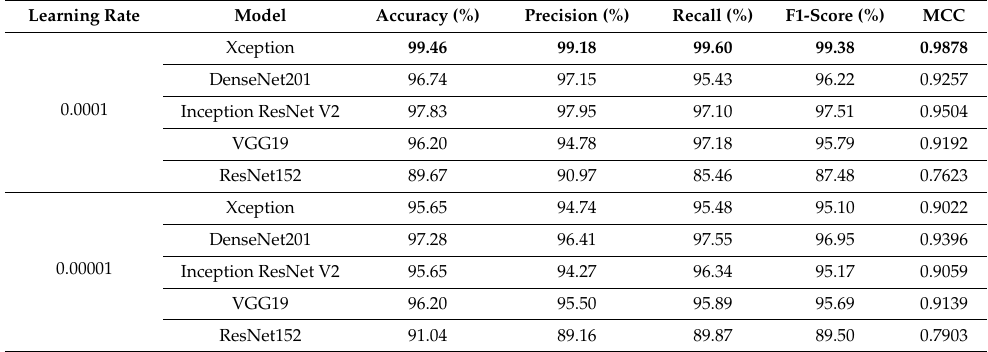
Table 8. Results of 400 × magnification factor in binary classification mode; the highest results are shown in